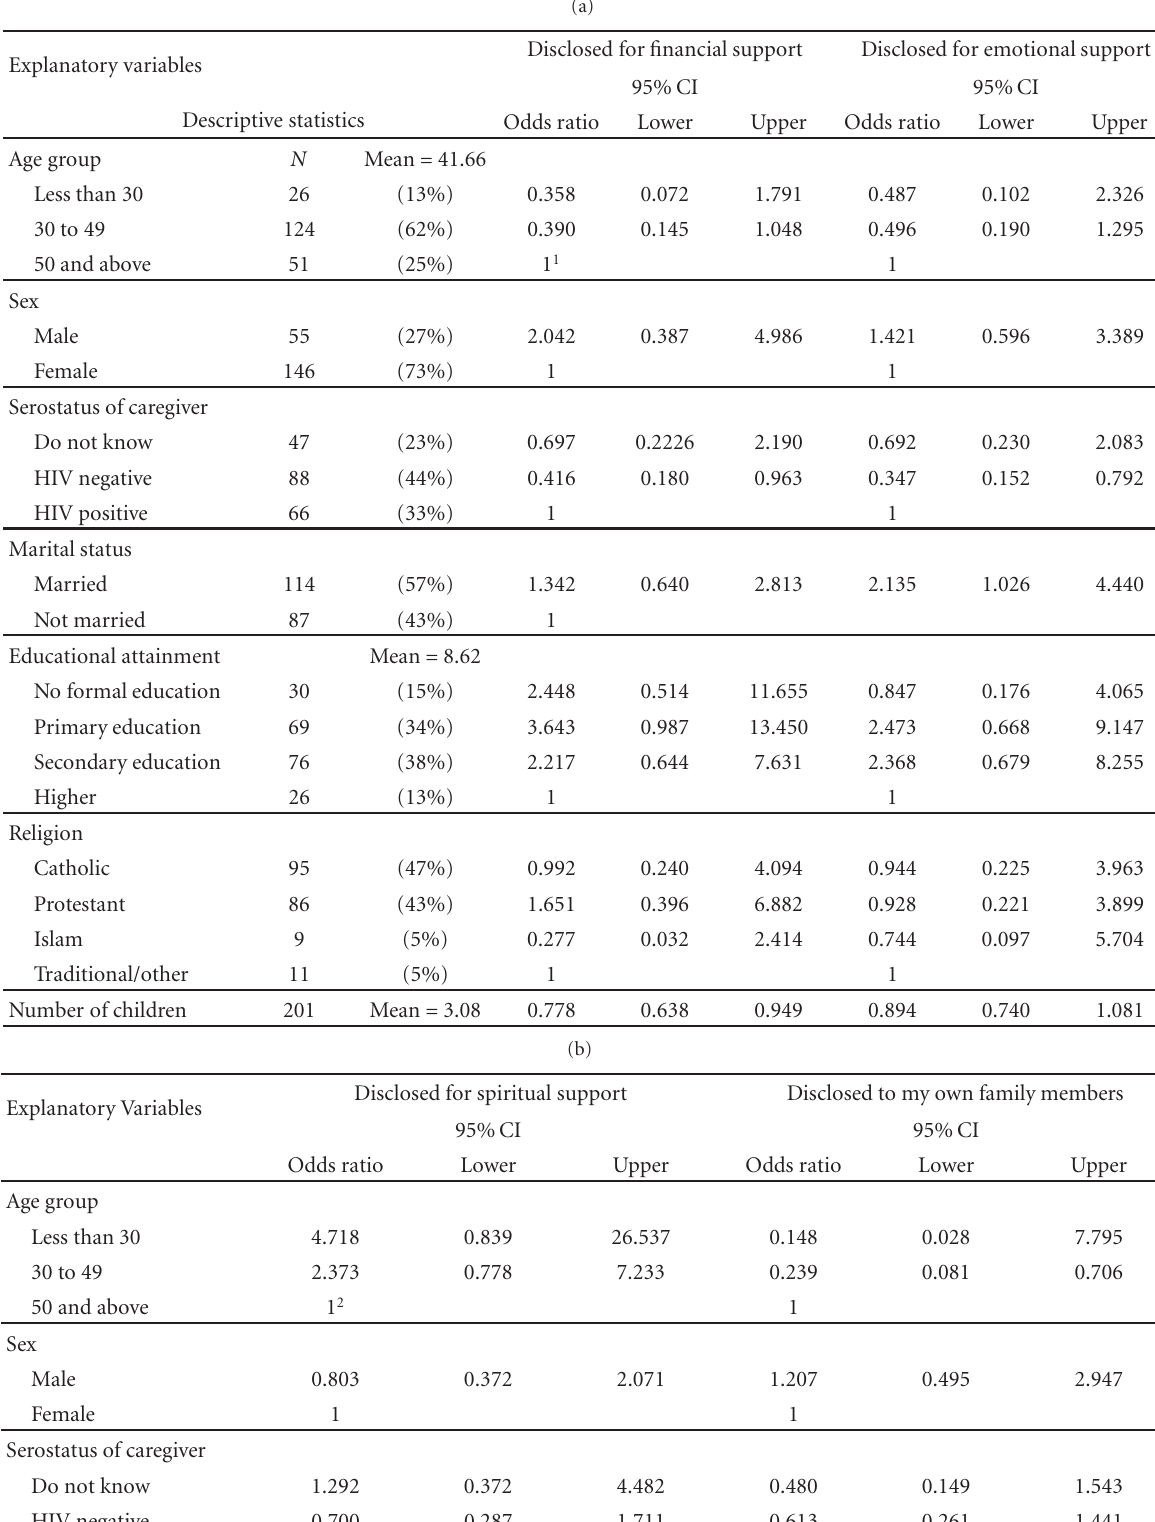
Table 1: (a) Descriptive statistics of sample and binary logistic models predicting caregivers’ disclosure of child’s serostatus. (b) Descriptive statistics of sample and binary logistic regression models predicting caregivers’ disclosure of child’s serostatus ( N = 201). ( (1,2,3) Reference categories have odds ratios =